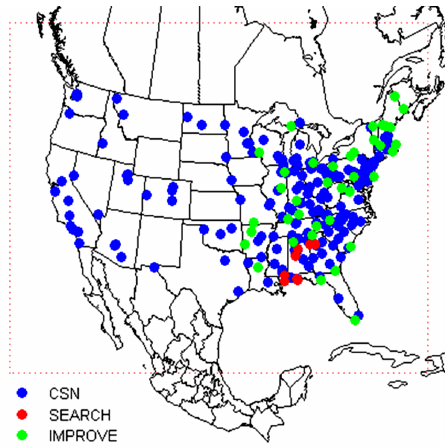
Figure 1. Modeling domain (dotted, red line) and CSN, SEARCH, and IMPROVE monitors used for model development, application, and